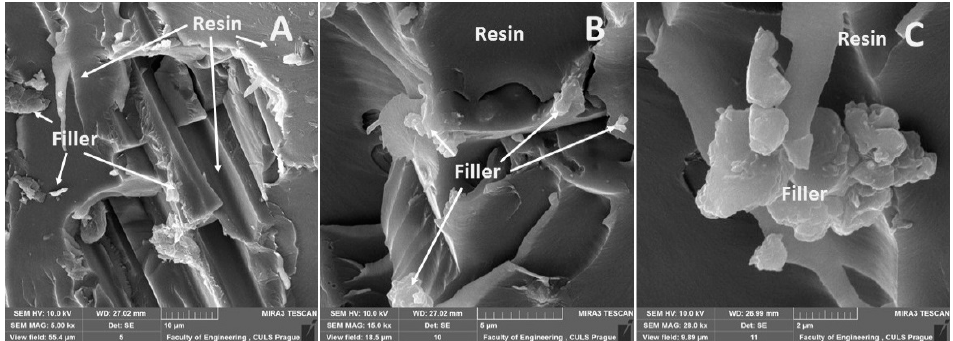
Figure 7. SEM micrographs—static tensile test of composite materials: ( A ) fracture surface of adhesive E5/TFF/100:26/C (mag 5.0k×), ( B ) fracture surface of adhesive E5/TFF/100:26/C (mag 15.0k×), ( C ) fracture surface E5/TFF/100:26/C with detailed view of filler carbon powder (mag 28.0k×).